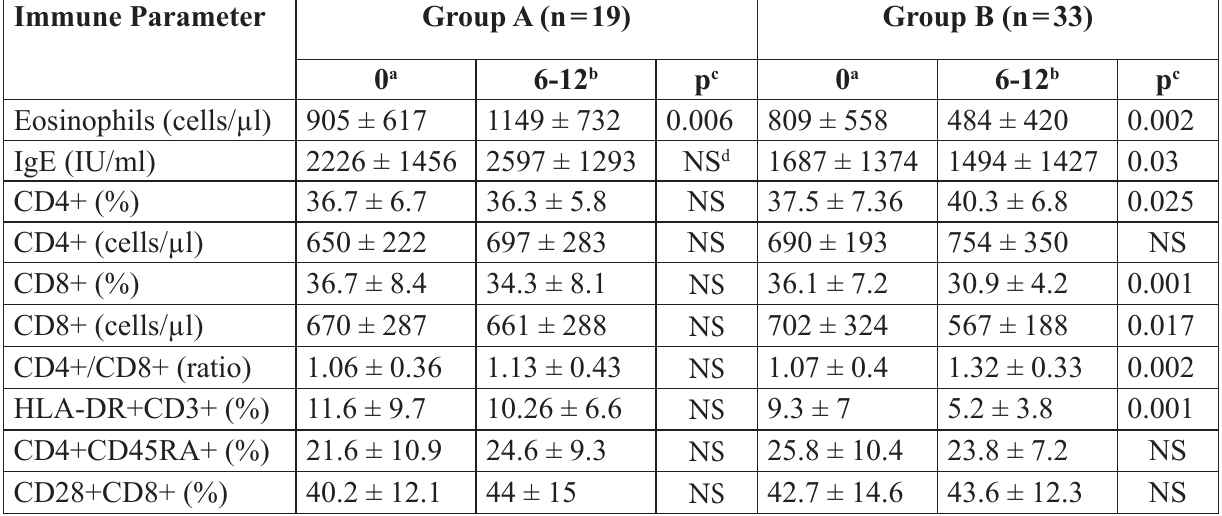
Table 3. Immune parameters (mean±SD) in Group A (in which helminths were not eradicated) and Group B (in which helminths were eradicated) at time 0 and 6 to 12 months